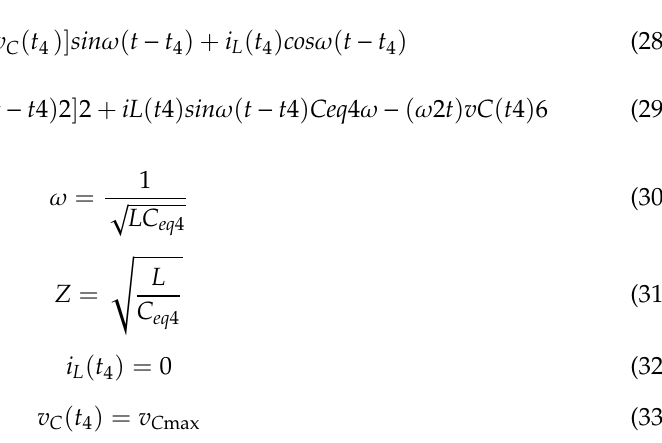
Figure 8. Mode 5 principle: ( a ) the equivalent circuit; ( b ) the Laplace transform circuit.